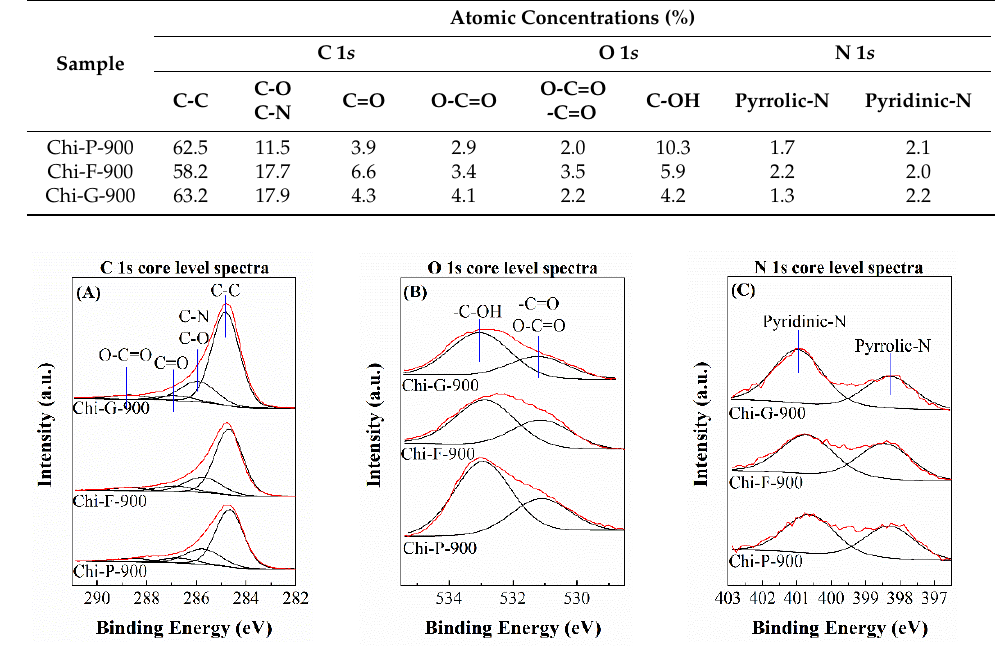
Figure 7. Thermogravimetric( A ) and differential thermal analysis ( B ) of Chi-P, Chi-F and Chi-G precursors.